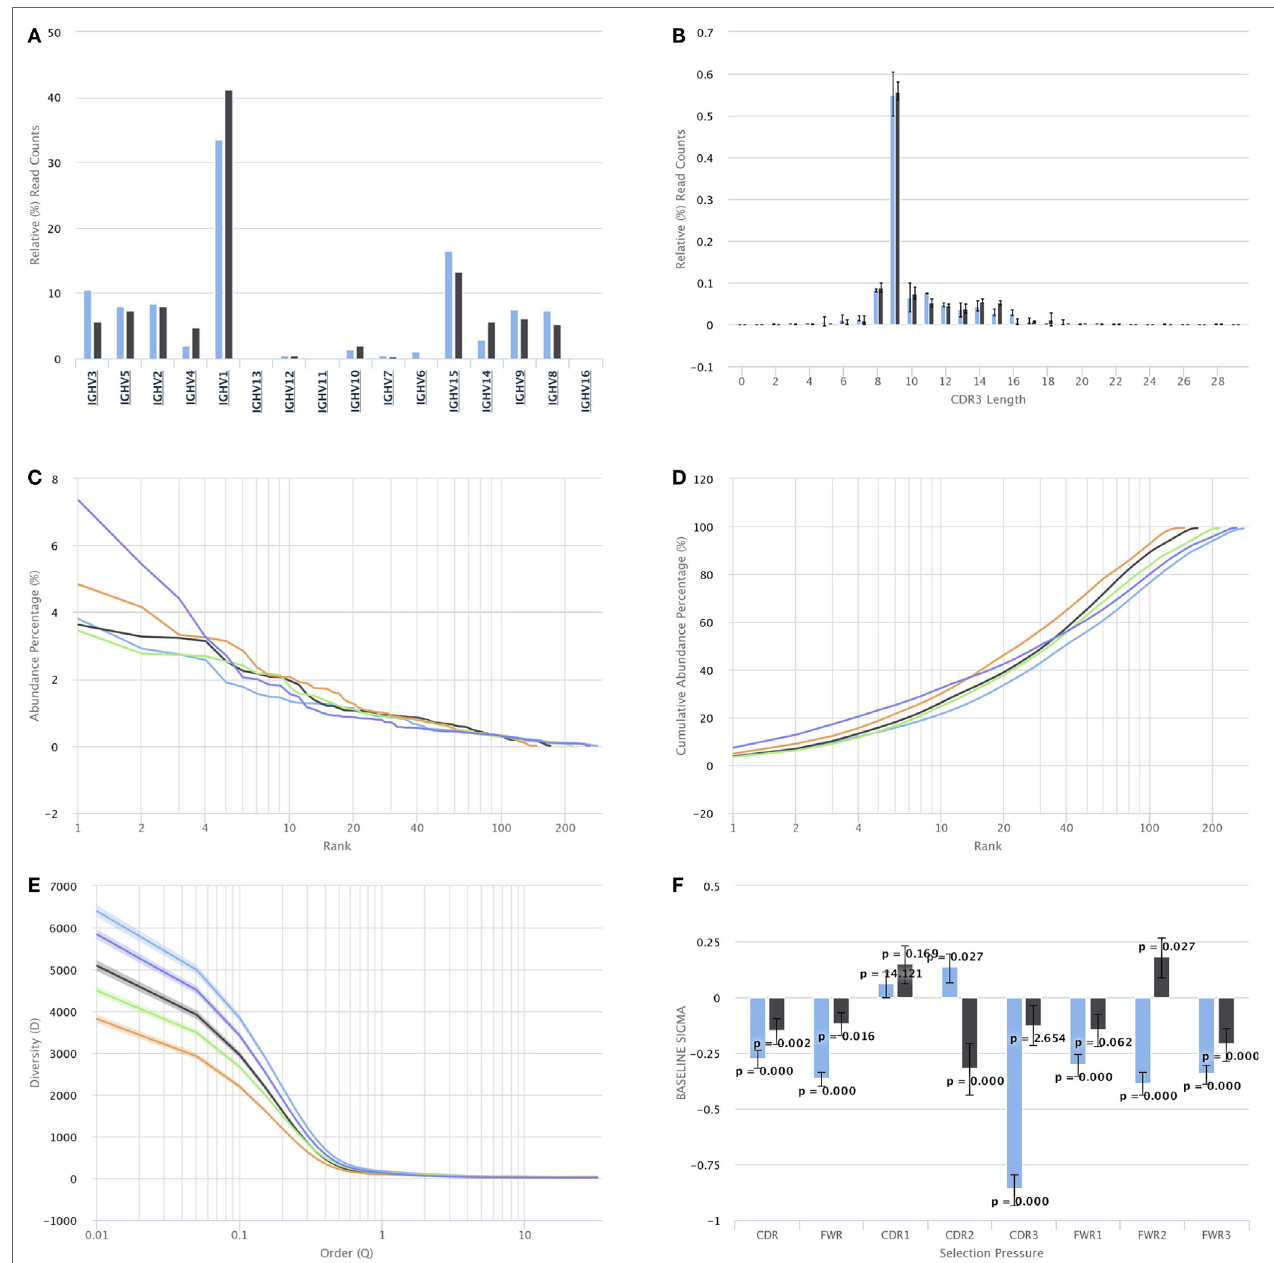
FIguRe 5 | Repertoire characterization and comparison visualizations. For simplicity, the interface buttons for selecting which samples and sample groups to display are not shown. Full size versions of the figures are provided in Supplementary Material. (A) Gene segment usage histogram. The graph shows IGH V gene segments along the X axis and the percentage of reads assigned to each V gene segment along the Y axis. The percentage is currently being displayed for two samples, as indicated by the blue and black bars. (B) CDR3 length histogram. CDR3 length is shown on the X axis, and the percentage of reads with that CDR3 length is shown on the Y axis. The percentage is currently shown for two sample groups as indicated by the blue and black bars. When the data for sample groups, rather than samples, are displayed, the bar height represents the average percentage across all samples in the group, and the error bars indicate the SD. (c) Ranked clonal abundance percentage. Each colored line represents a sample with the clones ranked from highest abundance (rank 1) to lowest abundance along the X axis and the corresponding percentage of reads for each clone along the Y axis. (D) Cumulative clonal abundance. Each colored line represents a sample with clones ranked from highest abundance (rank 1) to lowest abundance along the X axis and the cumulative percentage along the Y axis. (e) Diversity profile. Each colored line represents a sample where clonal diversity along the Y axis is calculated across a sweep of the ordering parameter ( Q ) along the X axis. A point of Q = 1 corresponds to the Shannon entropy. (F) Quantification of selection pressure for CDR and framework regions. Region is shown on the X axis, and the value of the selection parameter is shown on the Y axis. Negative bar values indicate negative selection, and positive bar values indicate positive selection. The error bars show the 95% confidence interval of the selection parameter along with a p -value for significance. Two B cell samples are currently displayed as indicated by the blue and black